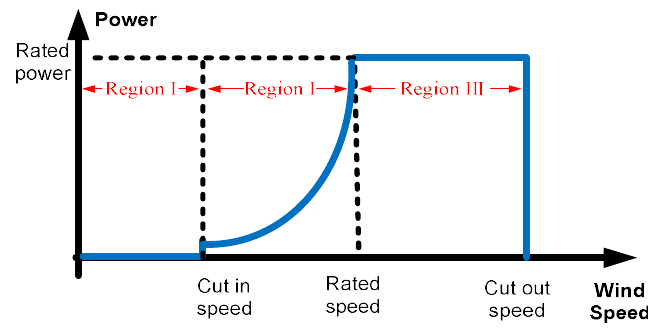
Figure 2. Power profile of wind turbines with variable speed.